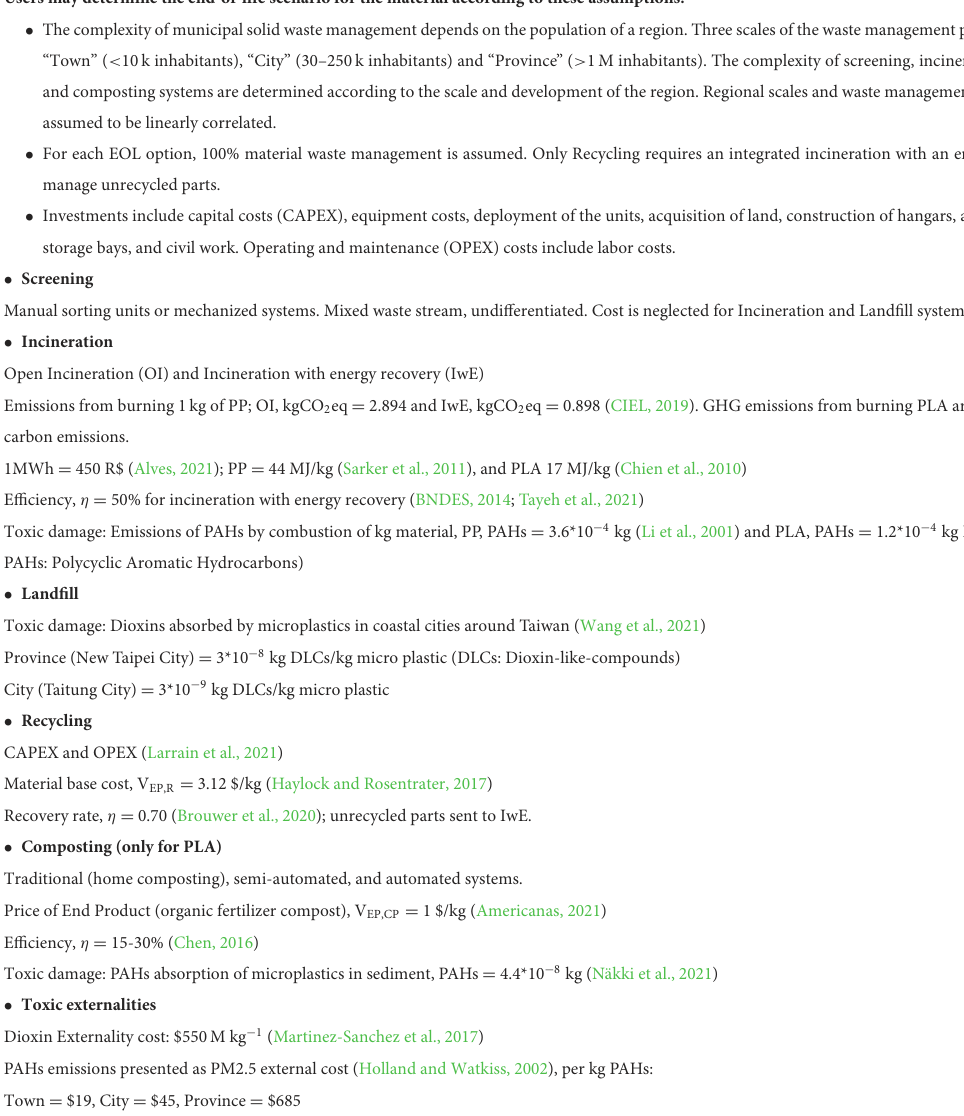
Users may determinethe end-of-life scenariofor the material according to